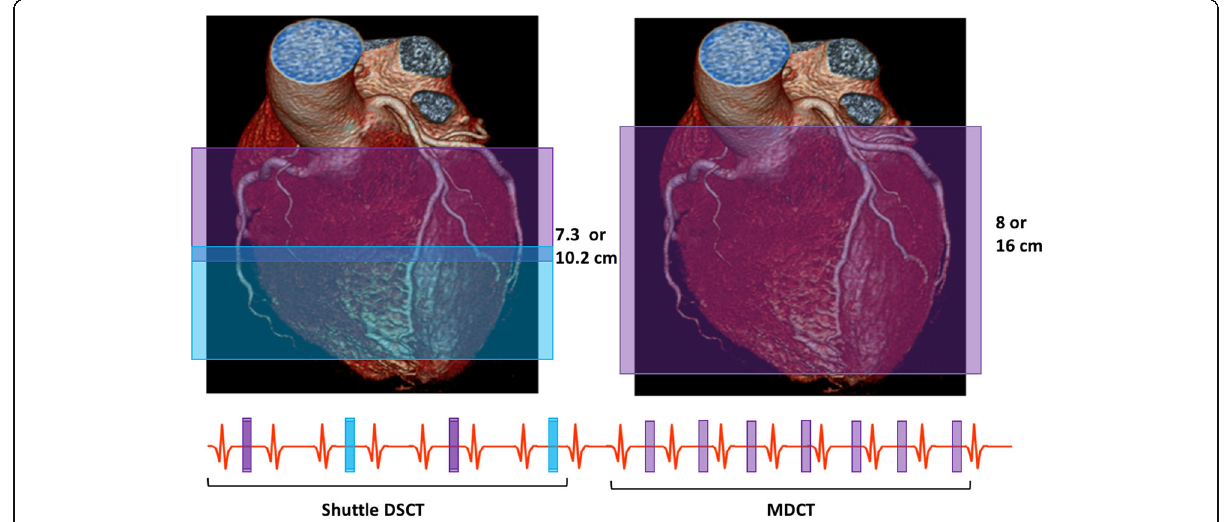
Fig. 2 Dual-source CT uses a shuttle mode, alternating table position using two acquisitions merged into one image, to get a z -axis of 7.3 or 10.2 cm for the second- and third-generation systems. Multi-detector CT systems use wide detector with 280 or 320 rows to reach a z -axis range of 8 or 16 cm, respectively. Both approaches allow for whole-heart